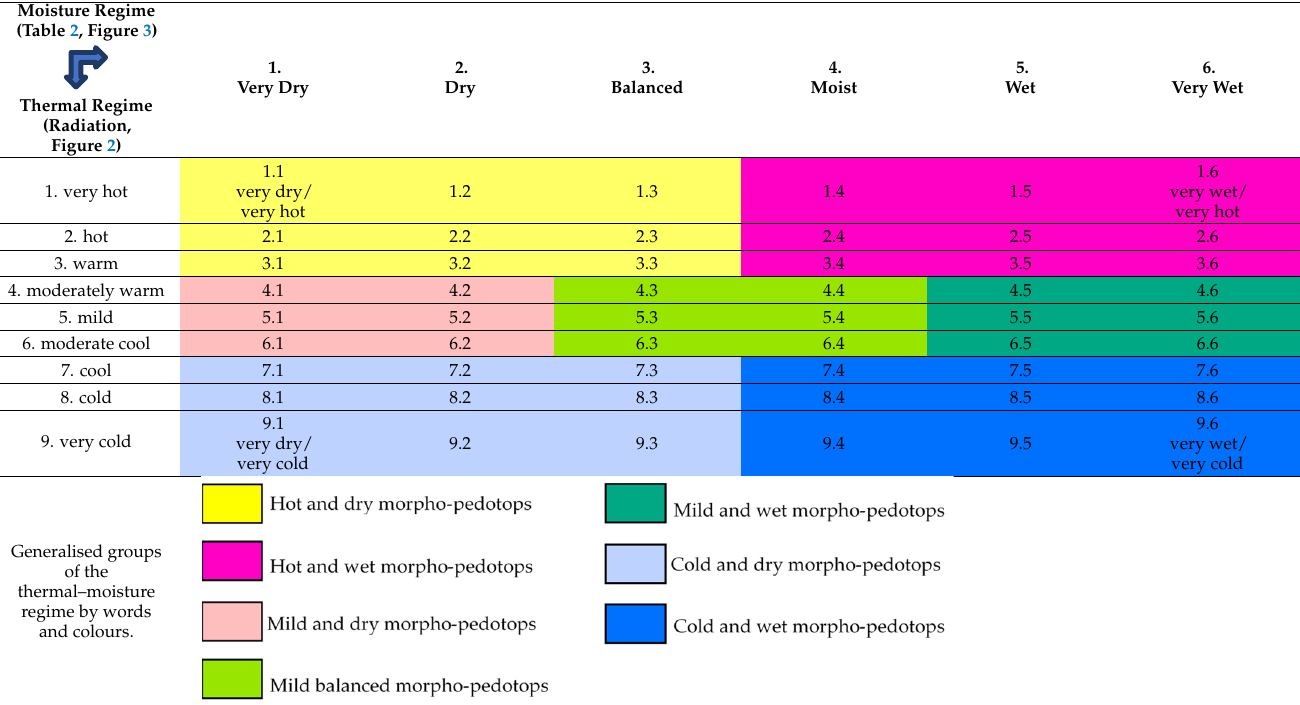
Table 3. Integrated characteristics of the morpho-pedotop thermal–moisture regime.